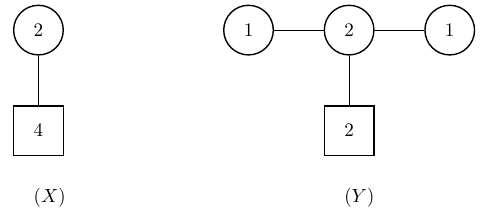
Figure 27 . A pair of dual linear quivers with unitary gauge groups.